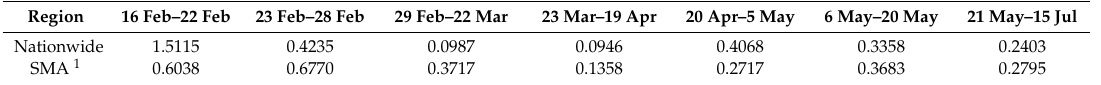
Table 2. Estimated transmission rates according to government’s social distancing